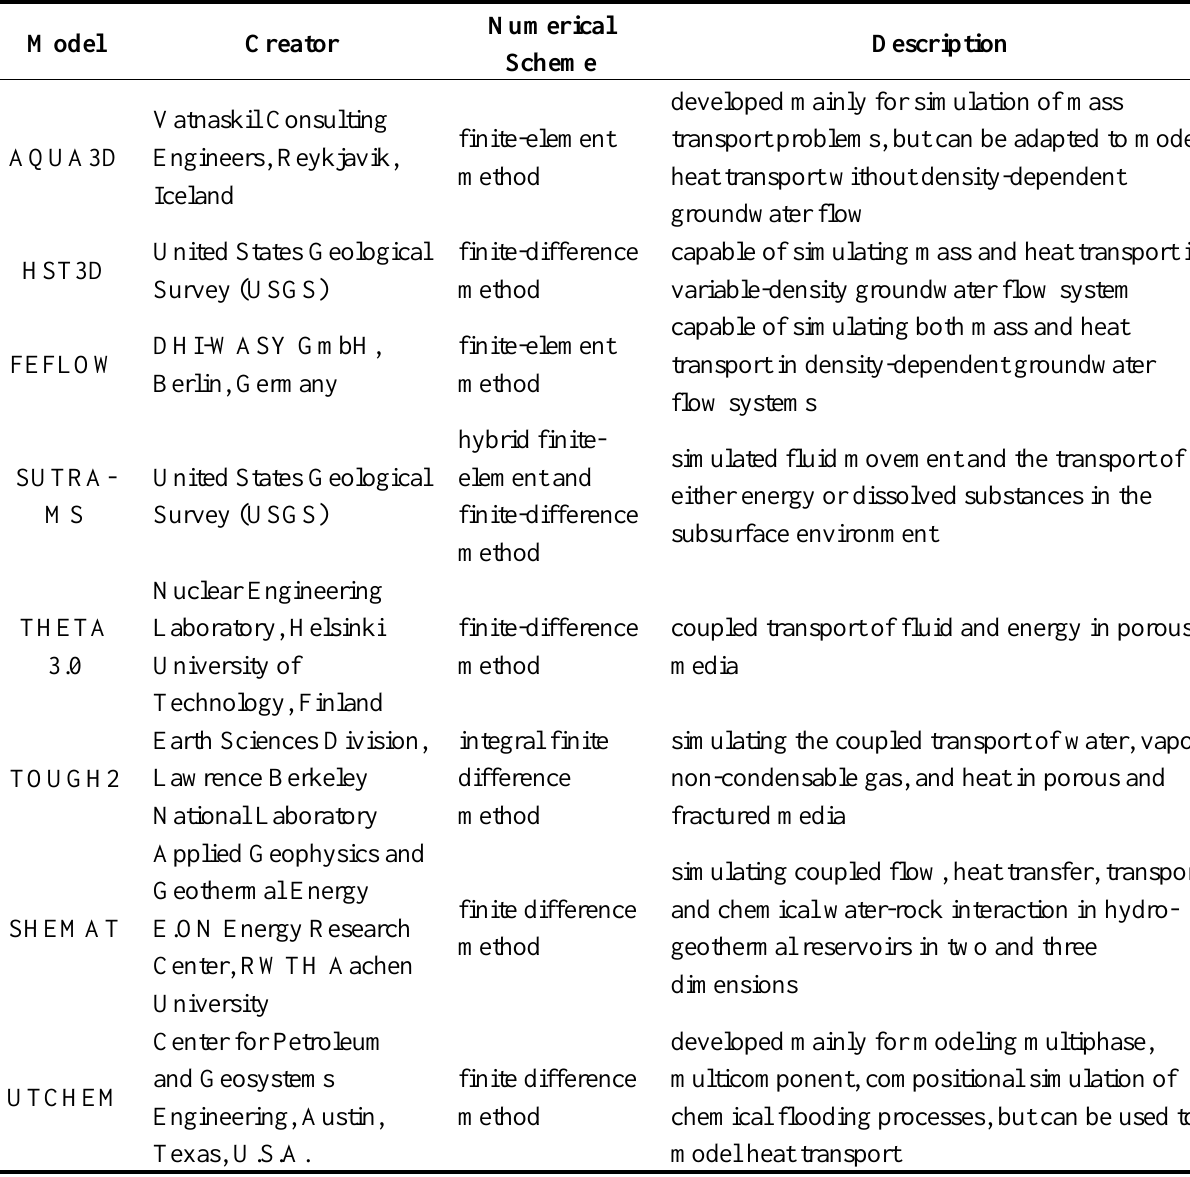
Table 1. Numerical models for groundwater and flow applicable to ATES